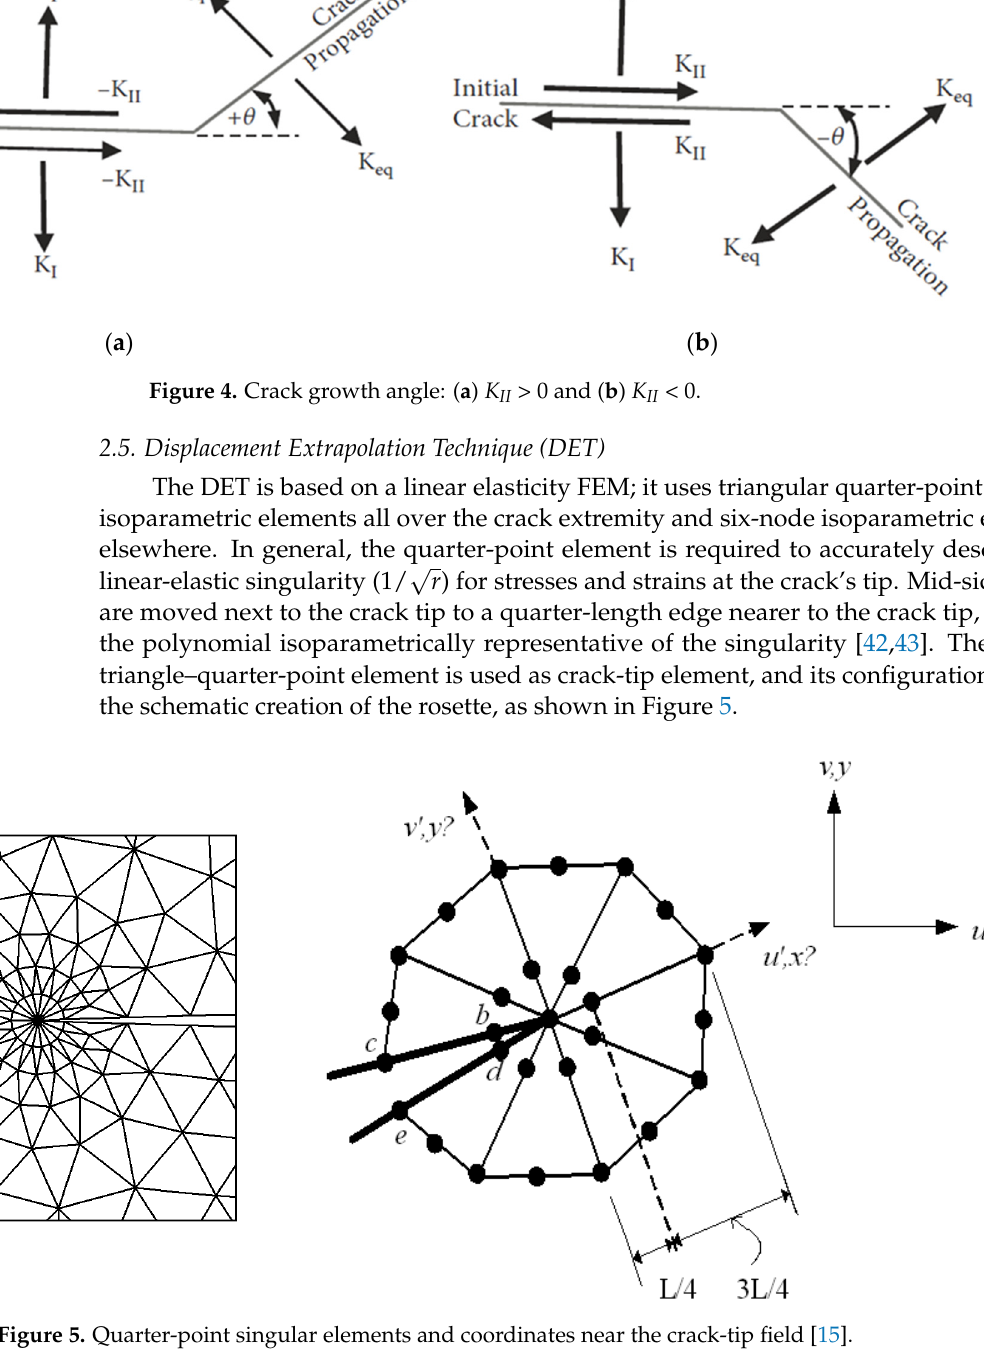
Figure 5. Quarter-point singular elements and coordinates near the crack-tip field [15].